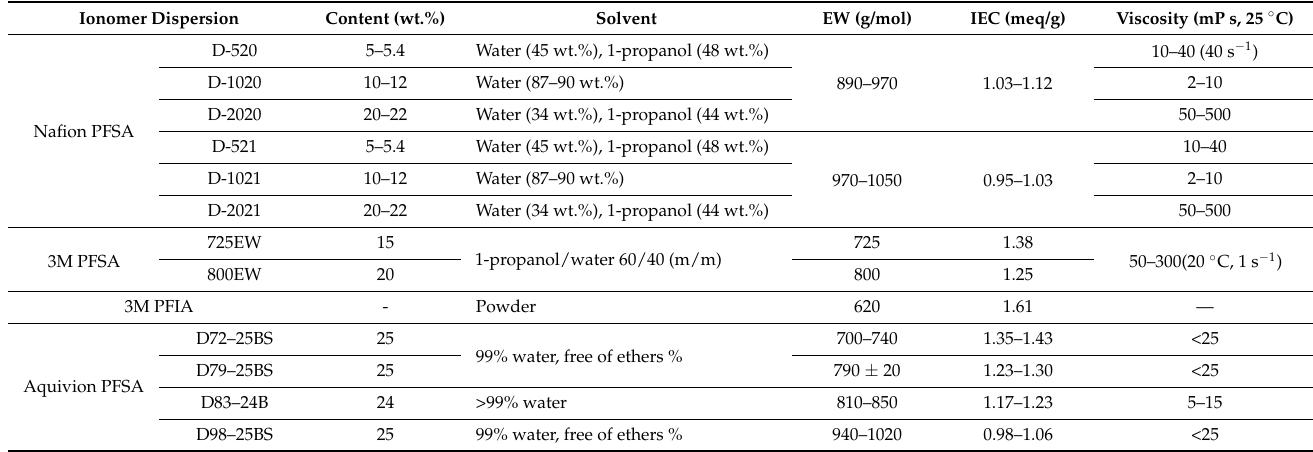
Table 1. The commonly used commercial ionomer dispersion solutions and their related parameters